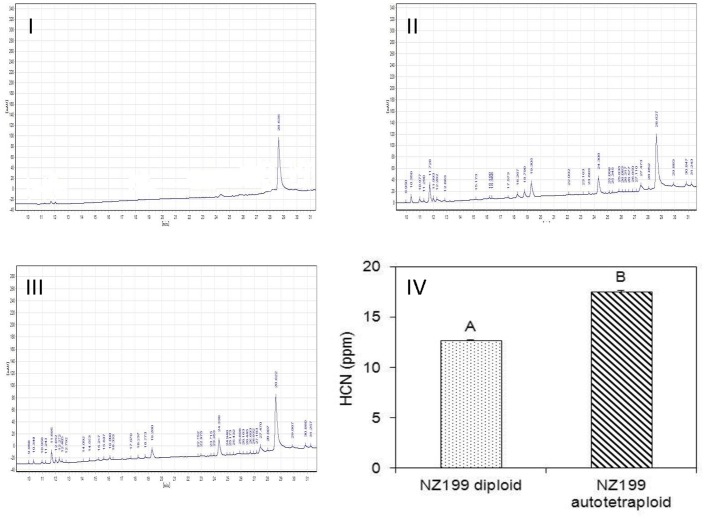
Chromatograms of cyanogenic glucoside of cassava cultivar leaves from NZ199 diploid and autotetraploid genotypes.I, HCN standard sample (0.5 ppm); II, NZ199 diploid genotypes; III, NZ199 autotetraploid genotype; IV, Extraction yield of cyanogenic glucoside from diploid and autotetraploid genotypes. Chromatographic conditions were: Kromasil 100-5C18 column (250×4.6 mm, 5 µm), gradient elution with aqueous acetonitrile, flow rate of 0.8 ml/min, UV detection at 215 nm, and column temperature at 30°C.